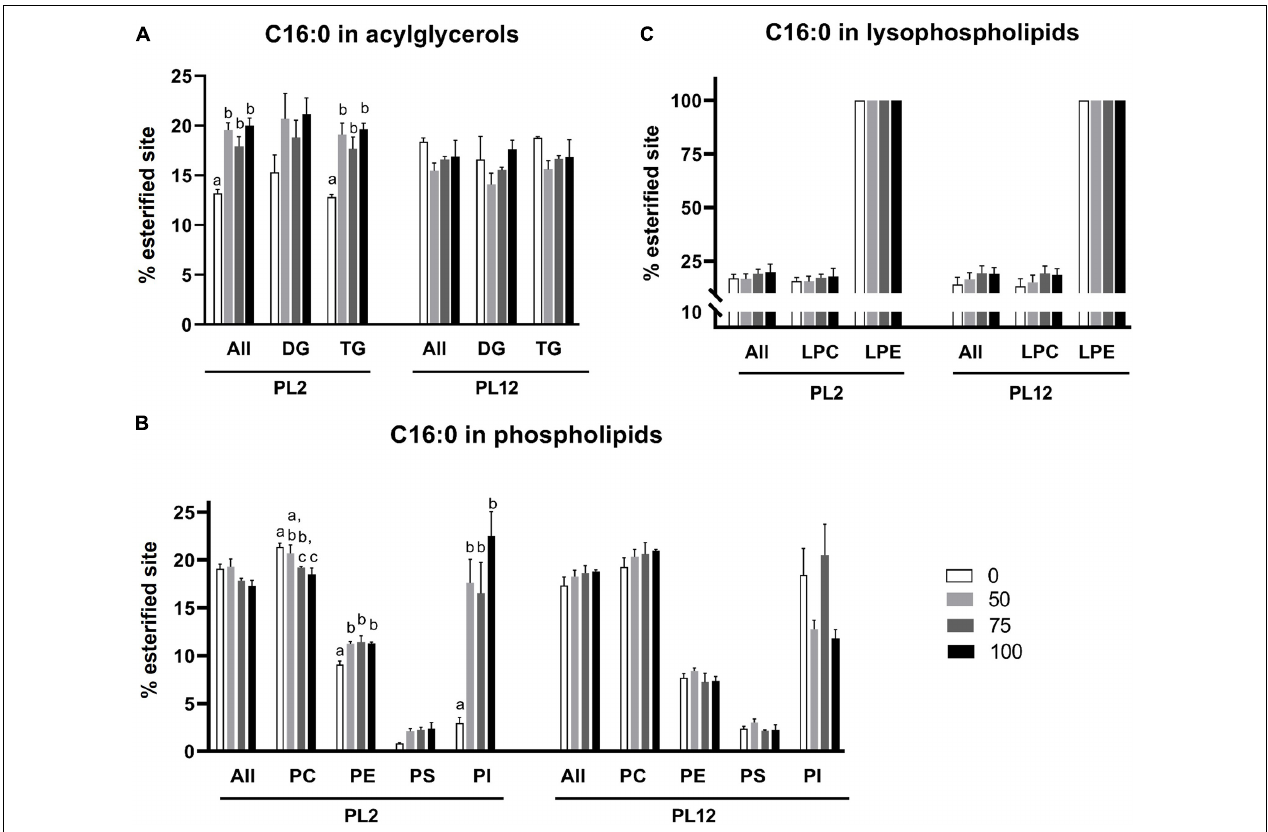
FIGURE 5 | Analysis of the 16:0 fatty acid distribution in lipid classes and subclasses by LC-HRMS. Percent of meal replacement was the percent of meals for which TW was replaced by AL. Percent esterified site is the percent of sites esterified with 16:0 compared with all the sites esterified with any types of fatty acids on the backbone. Error bars represent standard errors ( N = 3). Statistical analyses of the PL2 and PL12 data sets were performed separately, using ANOVA. Significant differences among subsets of treatment groups were determined by Duncan’s multiple range test ( P < 0.05); subsets with means not significantly different from one another are identified with the same letter above the bar. Bars with no specified letters mean no significant differences were identified among the groups ( P >